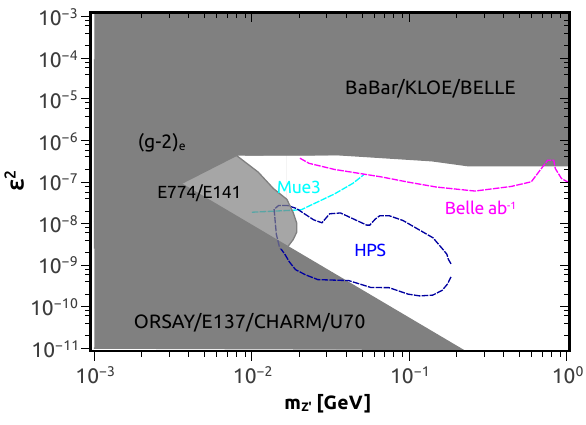
Figure 2 . Summary of experimental limits applicable to the model U(1) N and to the model U(1) Y 0 assuming g X (cid:28) (cid:15) . Current limits are in gray while projected ones in